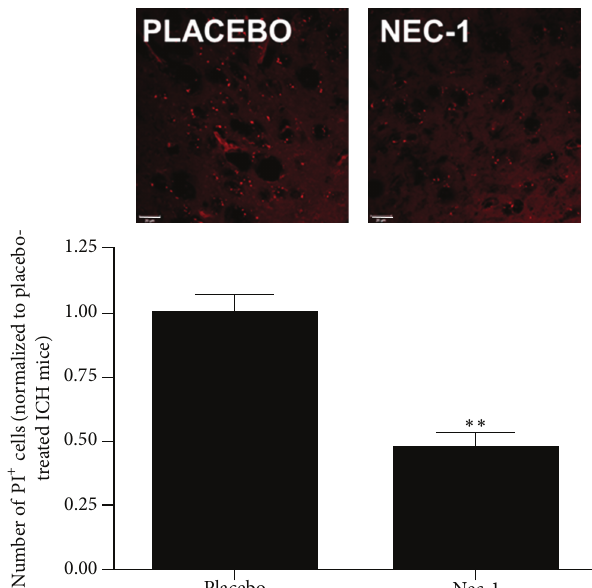
Figure 3: Nec-1 reduces cell death after ICH. Nec-1 administration at the time of ICH reduced perihematomal cell death, as assessed by PI staining. Top panels are representative images from placebo- or Nec-1-treated mice following ICH. Bottom panel depicts the quantification . Cell counts were normalized to placebo-treated ICH mice. Data are expressed of PI staining following treatment with Nec-1 or Nec- 1 inactive as mean ± SEM ( ∗∗ 𝑃 < 0.01 versus placebo; 𝑛 = 5 per